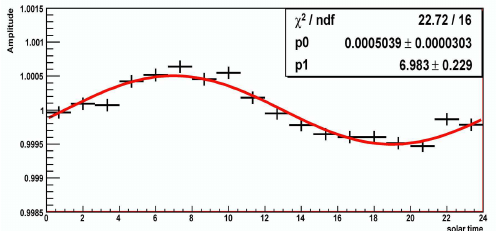
Figure 6: One-dimensional projection in right ascen- sion of the two-dimensional CR sky map in local solar time. The red line shows the best-fit to ARGO-YBJ data